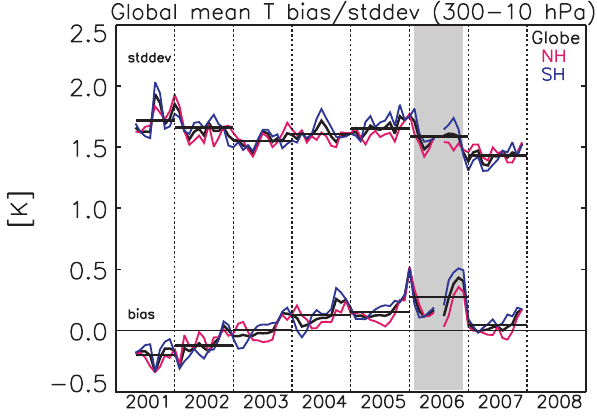
Fig. 4. Global, northern hemispheric and southern hemispheric monthly mean temperature bias and stddev between CHAMP and ECMWF for the pressure (altitude) range 300–10hPa. The left side of the shaded area denote the month when the ECMWF model lev- els have increased from 60 to 91 (February 2006), the right side of the shaded area corresponds to the beginning of the assimilation of GPS RO data at ECMWF (December 2006). The yearly horizontal lines denote the annual mean of the bias and stddev,